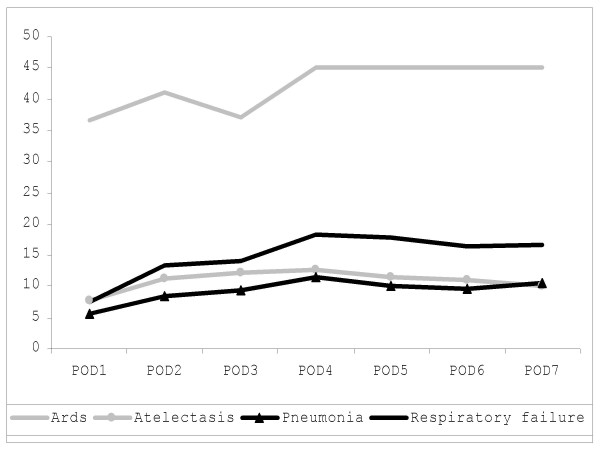
In complicated patients, the mean FLAM score increased during the first 4 postoperative days unregardless of the type of complication. ARDS patients raised rapidly to FLAM 45, which is the score of intubated patients by definition.